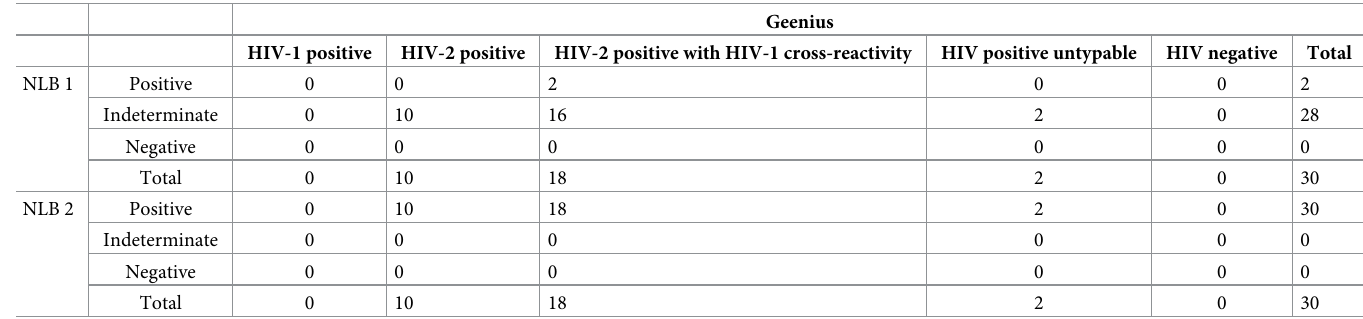
Table 3. Comparison of Geenius with NLB 1 and 2 results for HIV-2 panel